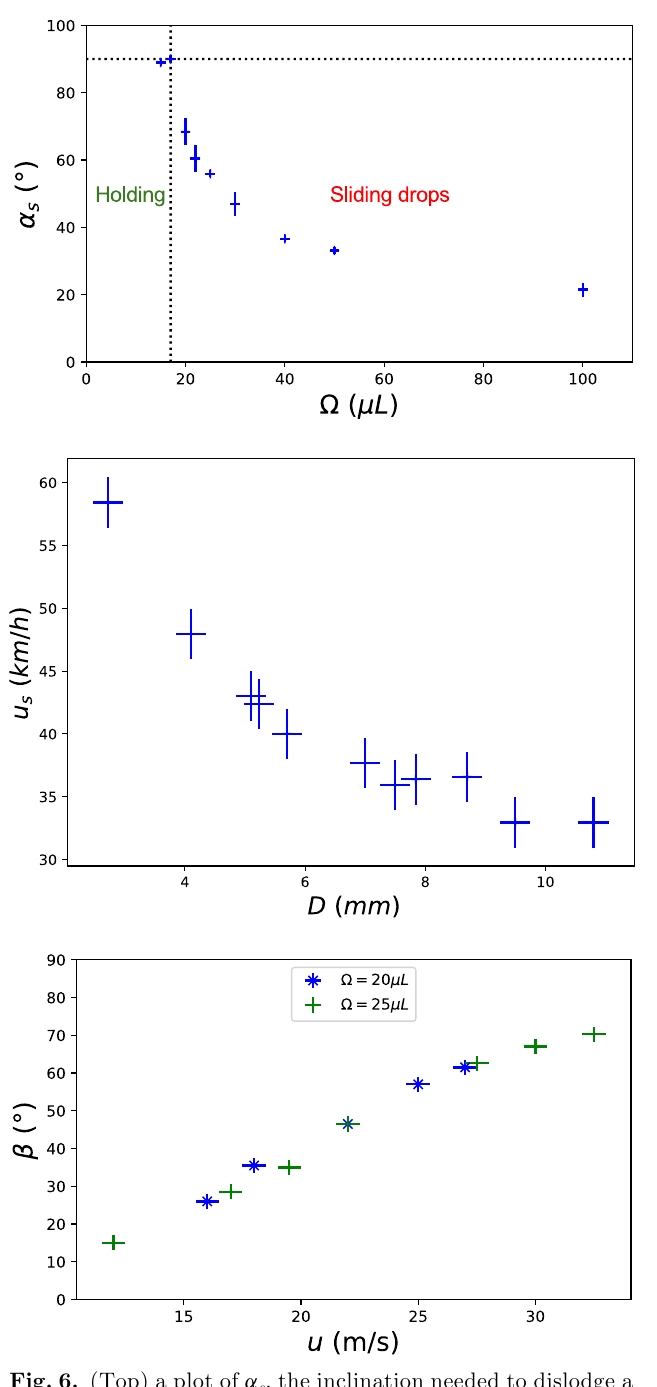
Fig. 6. (Top) a plot of a s , the inclination needed to dislodge a drop of water, is plotted against the volume V of the drop, put on a plane of acrylic. Dashed lines indicate limits for de fi nition of a s , which cannot exceed 90 ° (in this case the drop will not fall under its weight). Thus for volumes on the left of the vertical dashed line, a s is not de fi ned. (Middle) a plot of us, the minimum wind speed needed to dislodge a drop, is plotted against the diameter D of the drop lying on a plane of acrylic. (Bottom) the direction, taken by a drop of volume put on a vertical plane in front of a blower, is plotted against the speed u of the wind. Two values of the volume are used (blue dots: 20 m L , and green crosses: 25 m L ).